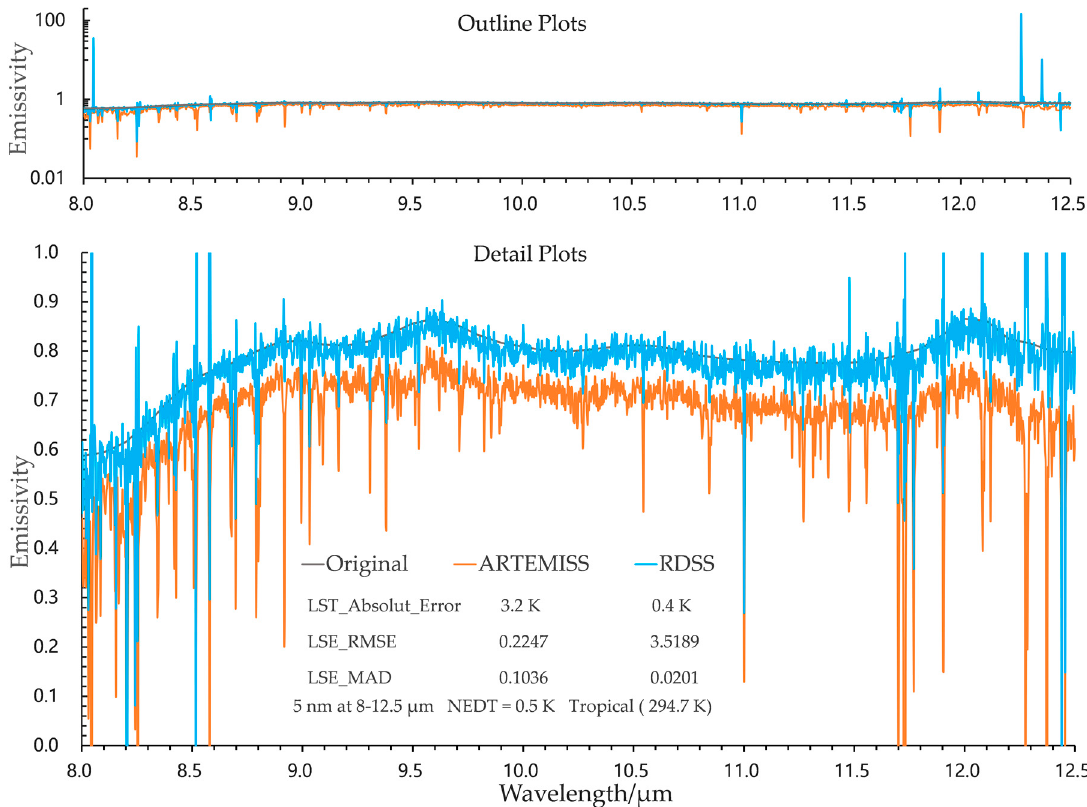
Figure 10. A case with a small LST error and LSE MAD but large LSE